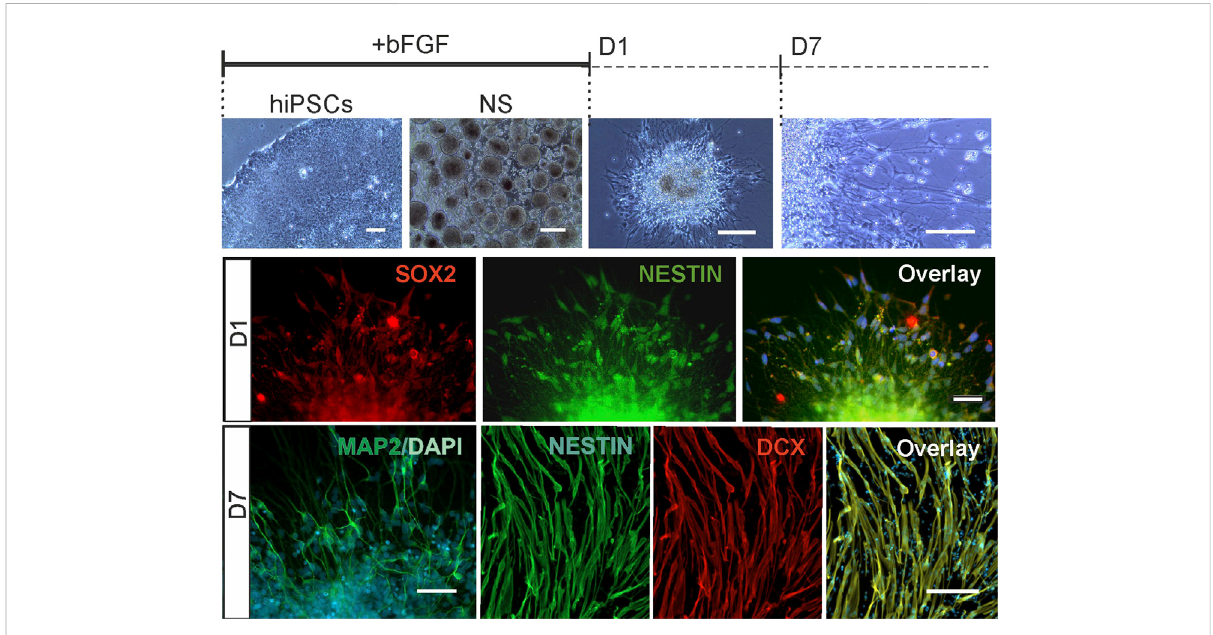
FIGURE 1 NPCs in human neurosphere model. Human iPSCs were differentiated to NPCs in neurospheres in the presence of mitogen (bFGF) and in neurospheres differentiated for 1 day (D1) and 7 days (D7) after withdrawal of mitogen. Representative bright fi eld images of human iPSCs, free fl oadingneurospheres,adifferentiatingneurosphereatD1,andcellsmigratedfromtheneurosphereatD7.AllNPCsexpressedpluripotencymarkers; D1 : Expression of SOX2 (red), NESTIN (green) and their overlay with nuclear stain DAPI, 4 ′ ,6-diamidino-2-phenylindole (blue) in D1 NPCs. D7 : ImmunoreactivecellsforneuronalmarkerMAP2inaD7neurophere,andcellsimmunostainedwithDoublecortin(DCX,red),Nestin(green)andtheir overlay with DAPI (blue). Scale bar 50 μ